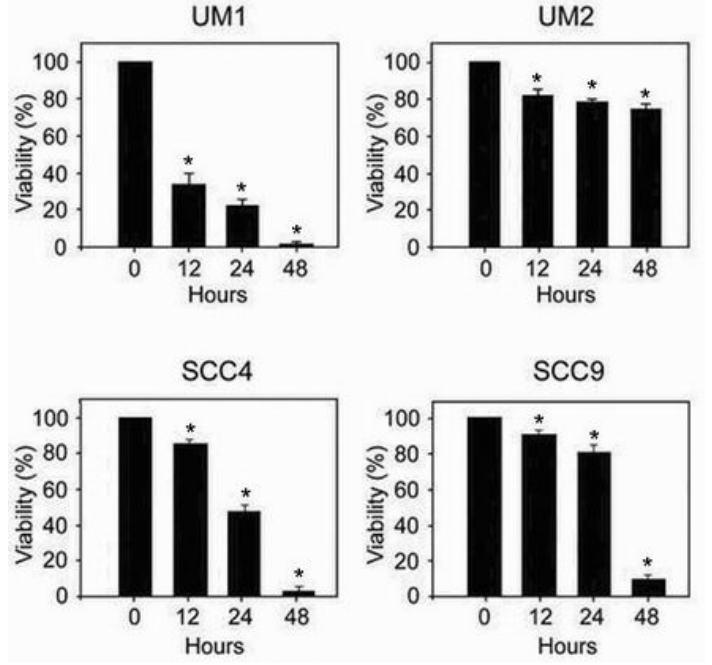
Figure 1. Effect of TS on viability of human oral squamous cell carcinoma (HOSCC) and normal human oral keratinocytes (NHOK). UM1, UM2, SCC4, and SCC9 cell lines were treated with 500 μ g/mL of TSL-1 for 12, 24 or 48 hours. At the indicated time points, cells were harvested for viability assays, using trypan blue exclusion. Results are presented as mean ± SE of three independent assays ( bars , SE; *, P < 0.05 compared with untreated cells). NHOK cells were treated or untreated with 250 or 500 µg/mL for 12, 24, or 48 hours. At the indicated time points, cells were harvested for viability assays. Columns , mean of the percentage of viability of cells from three independent experiment; bars , SE; #, P ≥ 0.05 compared with untreated NHOK control